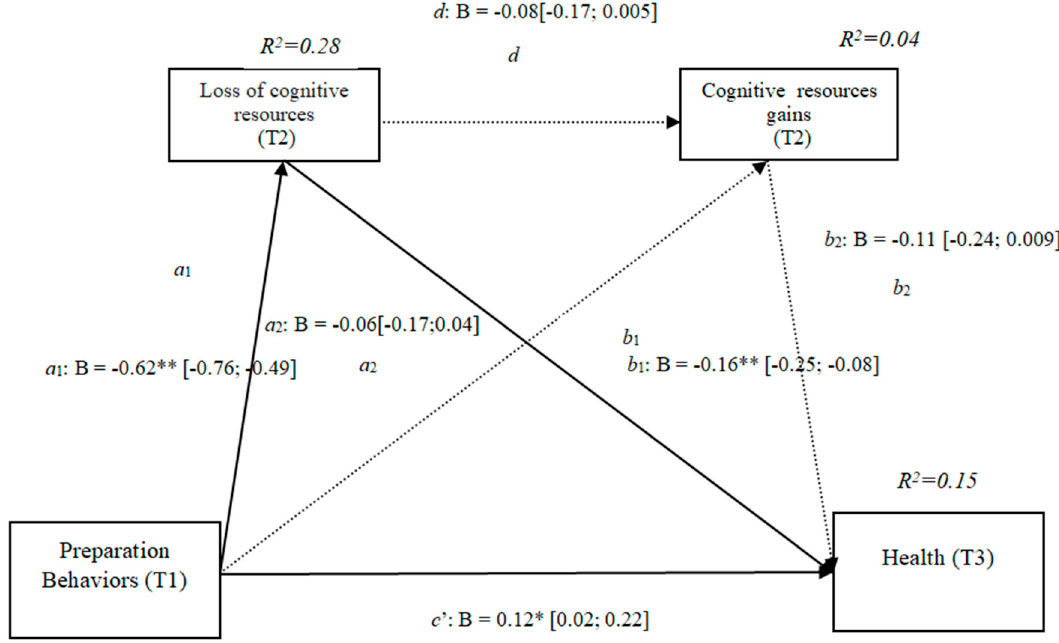
Figure 9. Non-standardized B coefficients, confidence intervals, and statistical significance for cognitive gains and losses. [95% CI]; * p < 0.05; ** p < 0.01.